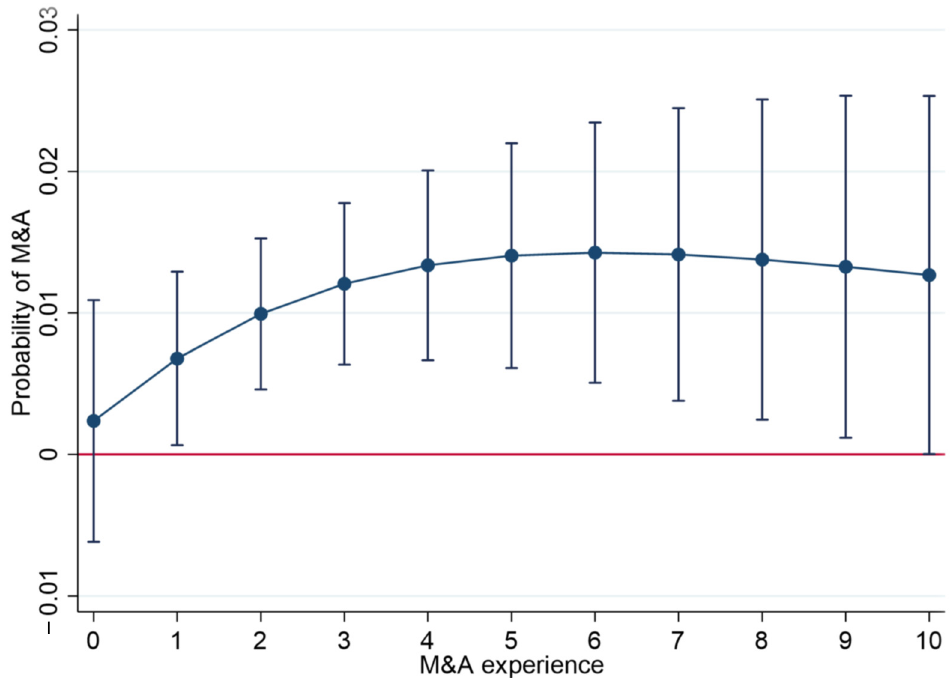
Figure 3. A graphical analysis of the interaction effect: predicted probability and confidence intervals (95%) of start-up M&A as a function of entrepreneurs with closure experience and the number of entrepreneurs with M&A experience.